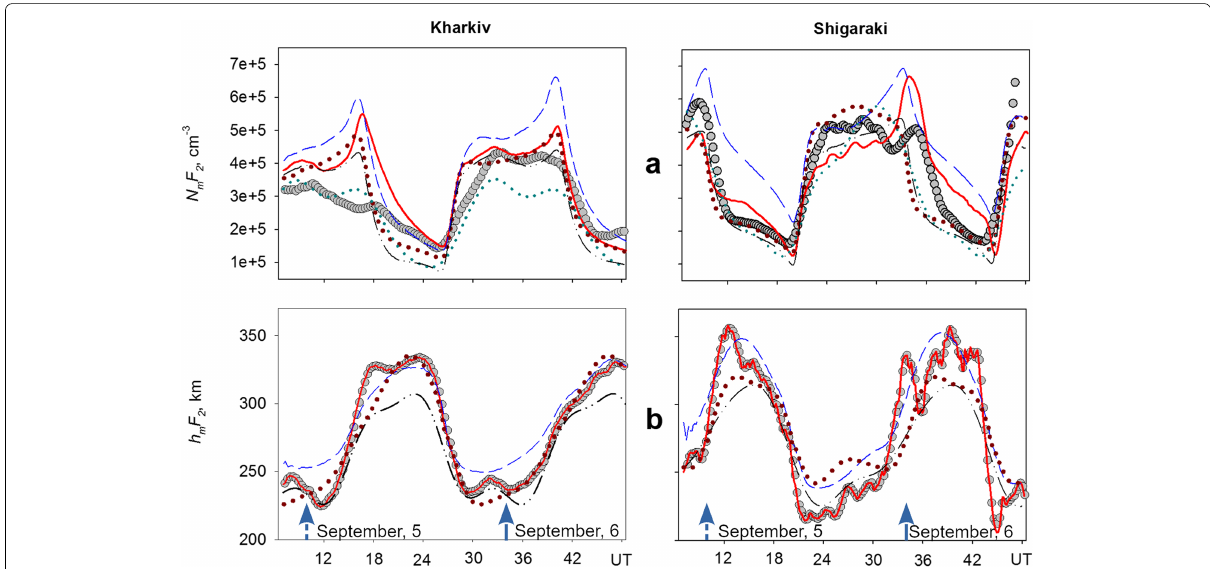
Fig. 3 Smoothed diurnal variations of N m F2 ( a ) and h m F2 ( b ). Gray circles denote 3-h averaged ionosonde N m F2 and ISR h m F2 observations. Solid red lines show the FLIP model simulations with the ISR h m F2 constraint together with doubled NRLMSISE-00 H density. The dashed blue lines are the FLIP simulations with the wind from the HWM-14 model. The dotted brown h m F2 lines are from AMTB-2013 and dotted brown N m F2 lines are from the FLIP model simulation using the AMTB-2013 h m F2 variation as the constraint. The black dash-dot lines show similar results when the SHU-2015 h m F2 is used in the FLIP model. The small green dotted N m F2 lines are from the IRI-2016 model. The solid arrows on the bottom panels denote the time of a maximum AE index burst ( 800 nT). The dashed arrows show the same local time on the preceding day when the AE index was ∼